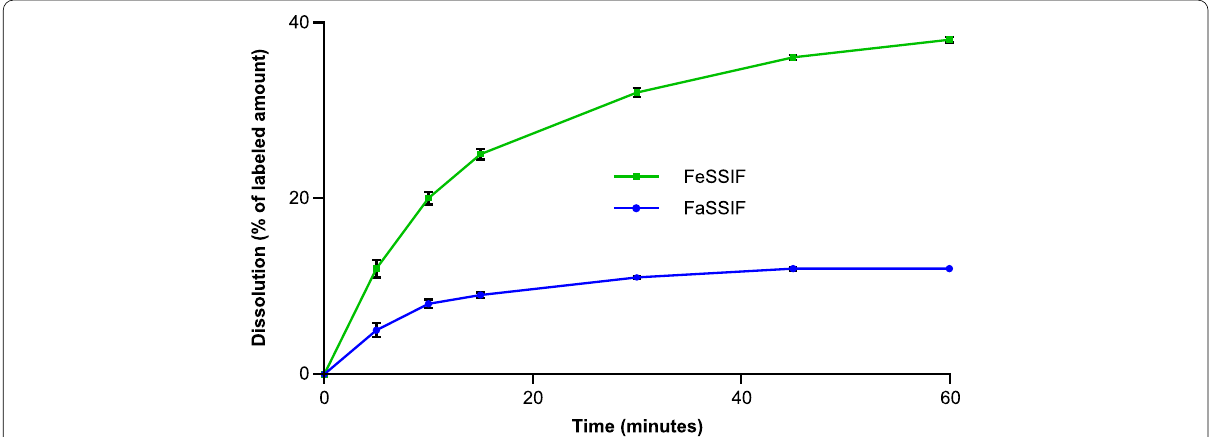
Fig. 1 Mean dissolution of vericiguat 10 mg intact tablet in FaSSIF and FeSSIF (both 500 mL; n within the data symbols. FaSSIF , fasted state-simulated intestinal fluid; FeSSIF , fed state-simulated intestinal